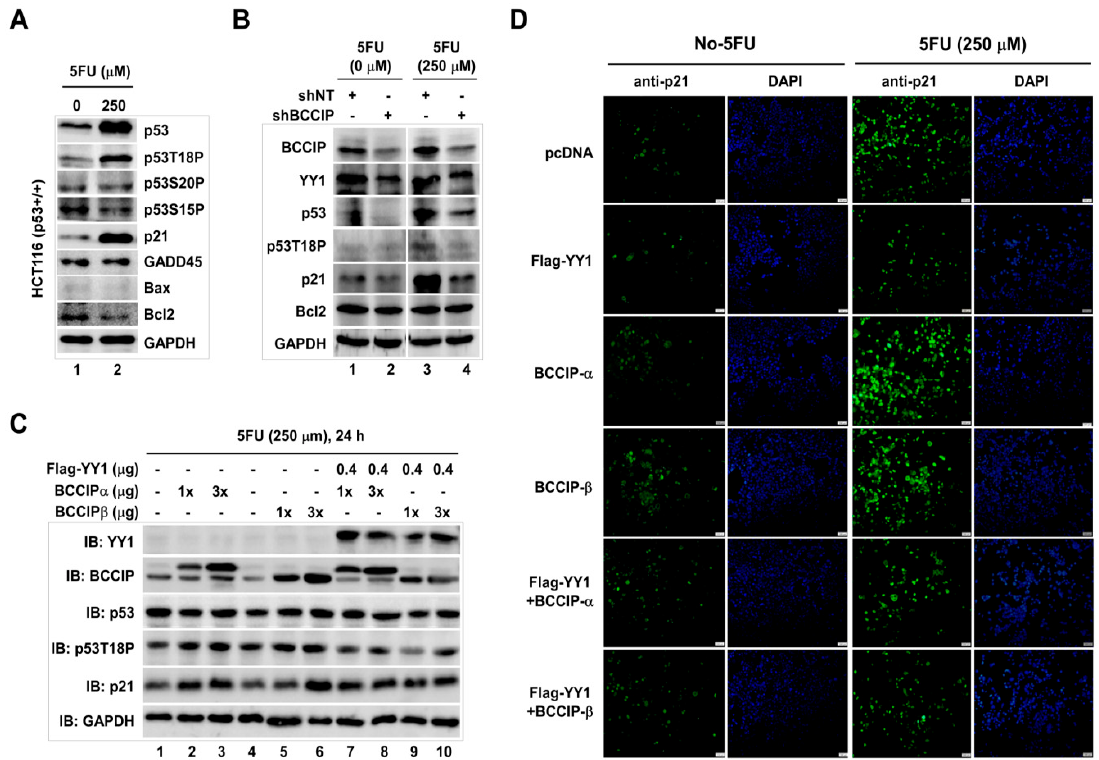
Figure 6. P53 downstream target gene p21 was coordinately regulated by YY1 and BCCIP in HCT116 (p53+/+) cells. ( A ) Induction of p53 by 250 μ M 5FU. Indicated proteins were analyzed by western blot with specific antibodies. ( B ) Impact of shBCCIP on 5FU-induced p53. shNT- and shBCCIP-transfected cells were treated with 0 and 250 μ M 5FU, and indicated proteins were measured by western blot with antibodies. ( C ) Coordinative effects of YY1 and BCCIP on p53. The experiment was designed as shown. Proteins in prepared lysate were analyzed by western blot. ( D ) Immune staining. Cells were transfected with indicated plasmids in the presence or absence of 5FU. Then, cells were stained with anti-p21 antibody. DAPI staining shows total nuclei. Scale bar indicates 200 μ m.